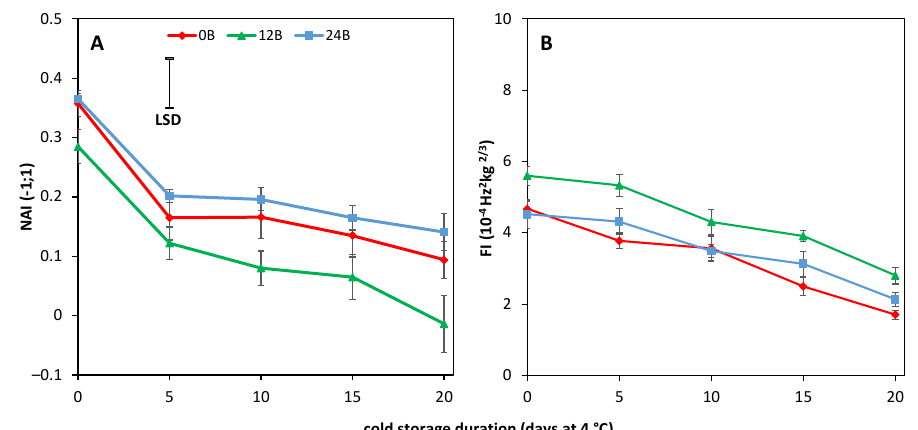
Figure 4. Average color development, expressed as NAI values ( A ), and average firmness development, expressed as FI index ( B ), for five red tomatoes during cold storage (4 °C), with indicated standard error. Red, green and blue symbols indicate cultivation with 0, 12 and 24% additional blue light, respectively. The LSD value in panel A indicates the presence of significant differences between light treatments.